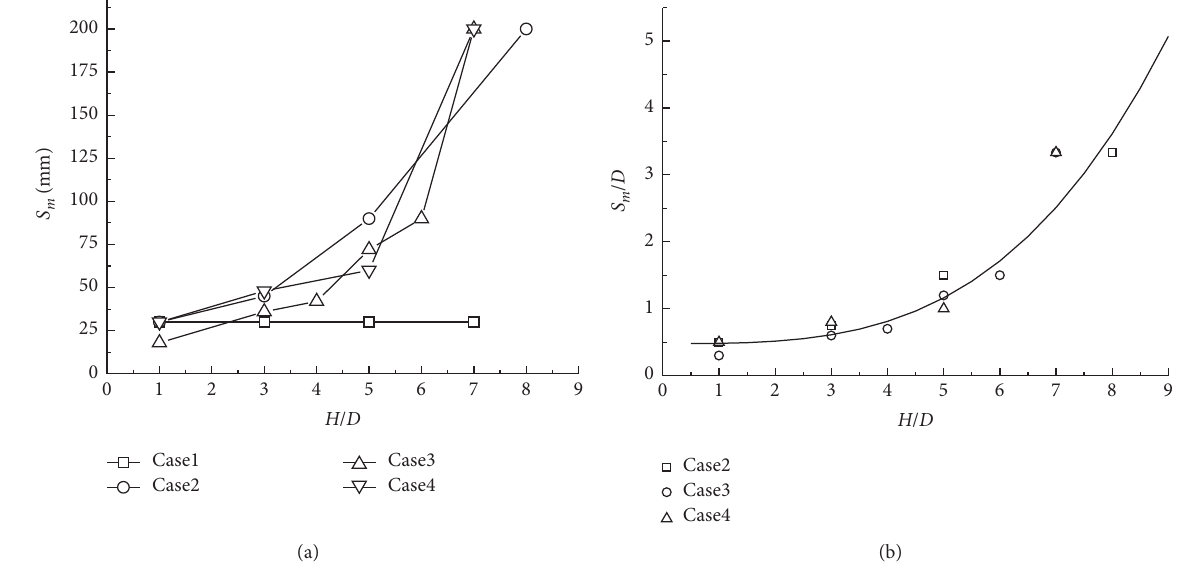
Figure 17: Plot of S m versus H/D . (a) Experimental data. (b) Comparison between the results calculated from formula (7) and the ex- perimental